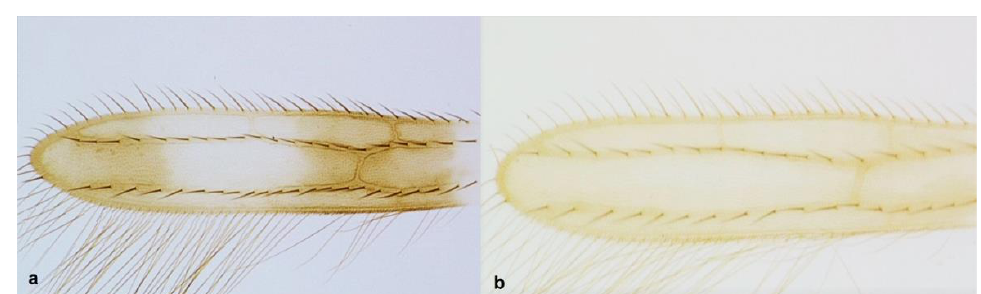
13 Anterior margin of fore wing between transverse veins with one row of setae (Figure